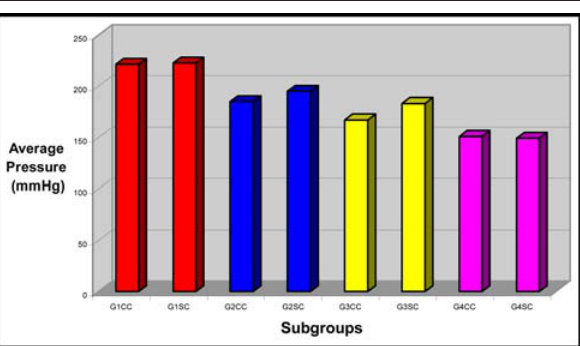
FIGURE 9 - Graphic distribution of the values for average rupture pressure by liquid distension (mmHg) for the eight subgroups